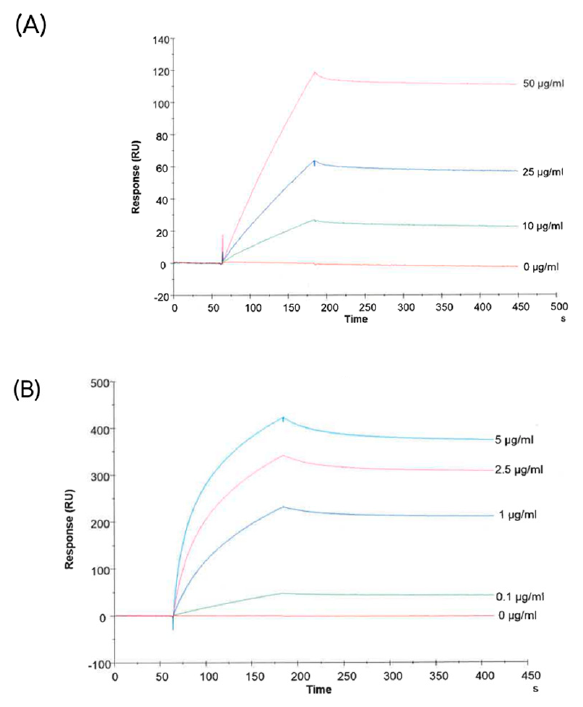
Figure 4. Characterization of an antibody against human CA-IX. Figures show the binding of the antibody with CA-IX-positive sEVs (from HEK293pRTS-CA9 cells) ( A ) and with the recombinant protein ( B ).